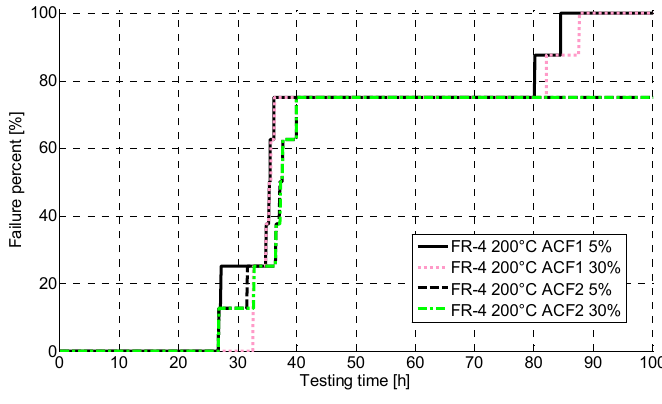
Figure 5. CDF for FR ‐ 4 at 200 °C.